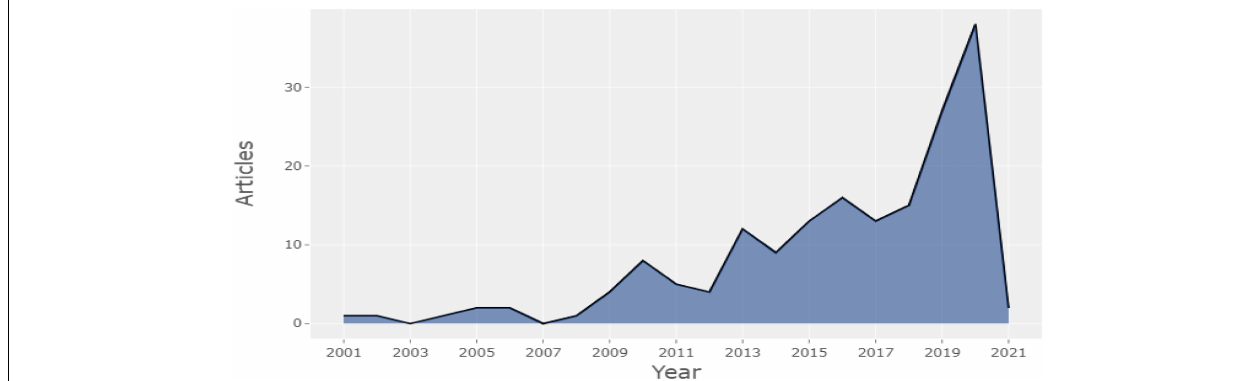
FIGURE 2 | Average article citations per year.